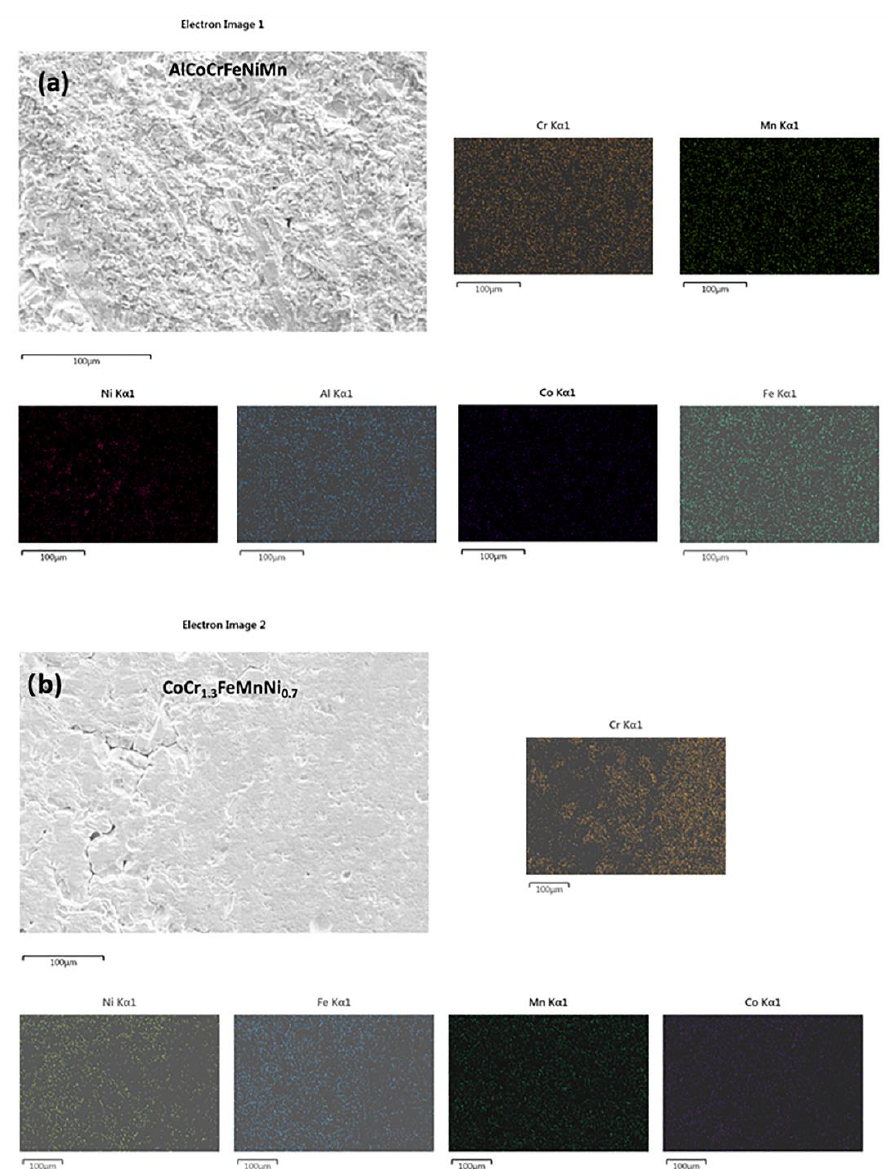
Figure A10. ( a ). SEM image and EDS elemental maps of additive manufactured HEA sample (AlCoCrFeNiMn). ( b ). SEM image and EDS elemental maps of additive manufactured HEA sample (CoCr 1.3 FeNi 0.7 Mn).